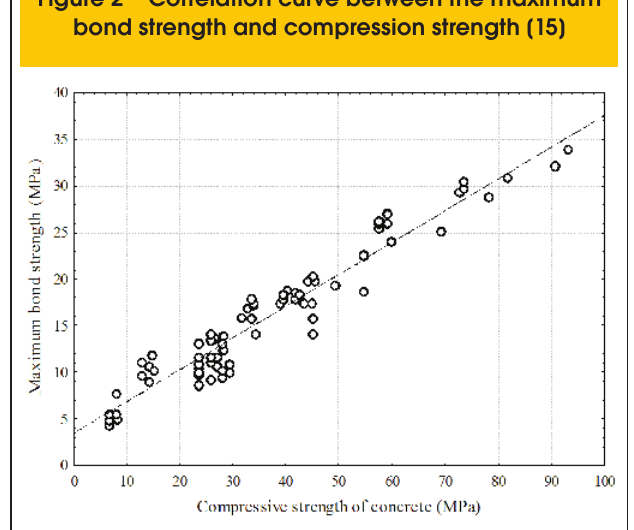
Figure 2 – Correlation curve between the maximum bond strength and compression strength